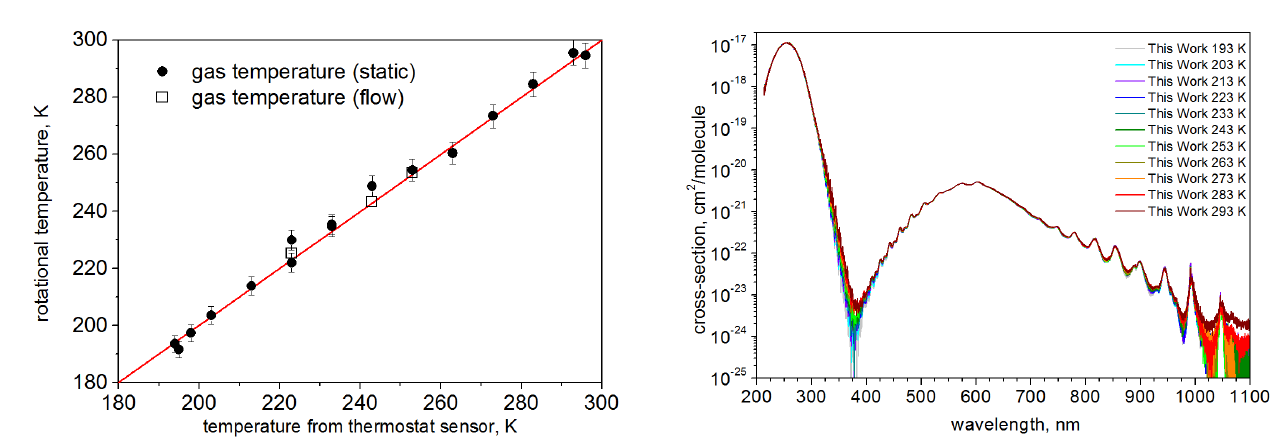
Fig. 2. Overview of our new ozone cross-section data in the UV/vis/NIR measured at 11 temperatures ranging from 193K to